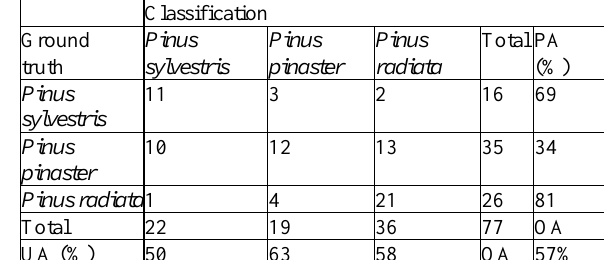
Table 3. Field work description. Sample plots: Number of points of each species sampled in field work. Selected sampling points: Number of points for which it was possible to obtain homogeneous training data. Training pixels: Number of pixels used as training data.